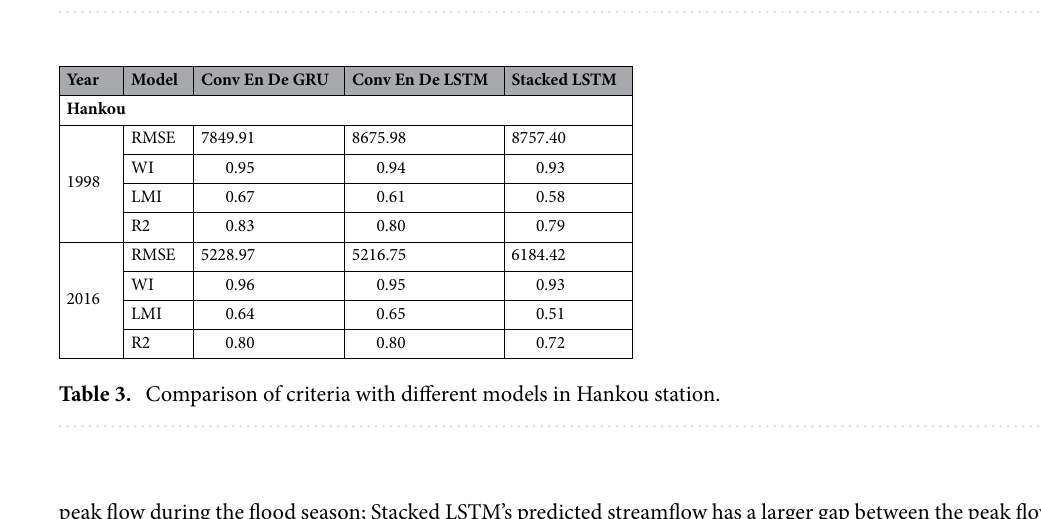
Figure 15. Comparison with different models in Datong station. The solid lines in A, C plot the predicted values using different models, and the blue dashed lines are the observed values. ( B, D ) Scatter plots of predicted and observed values for three models.